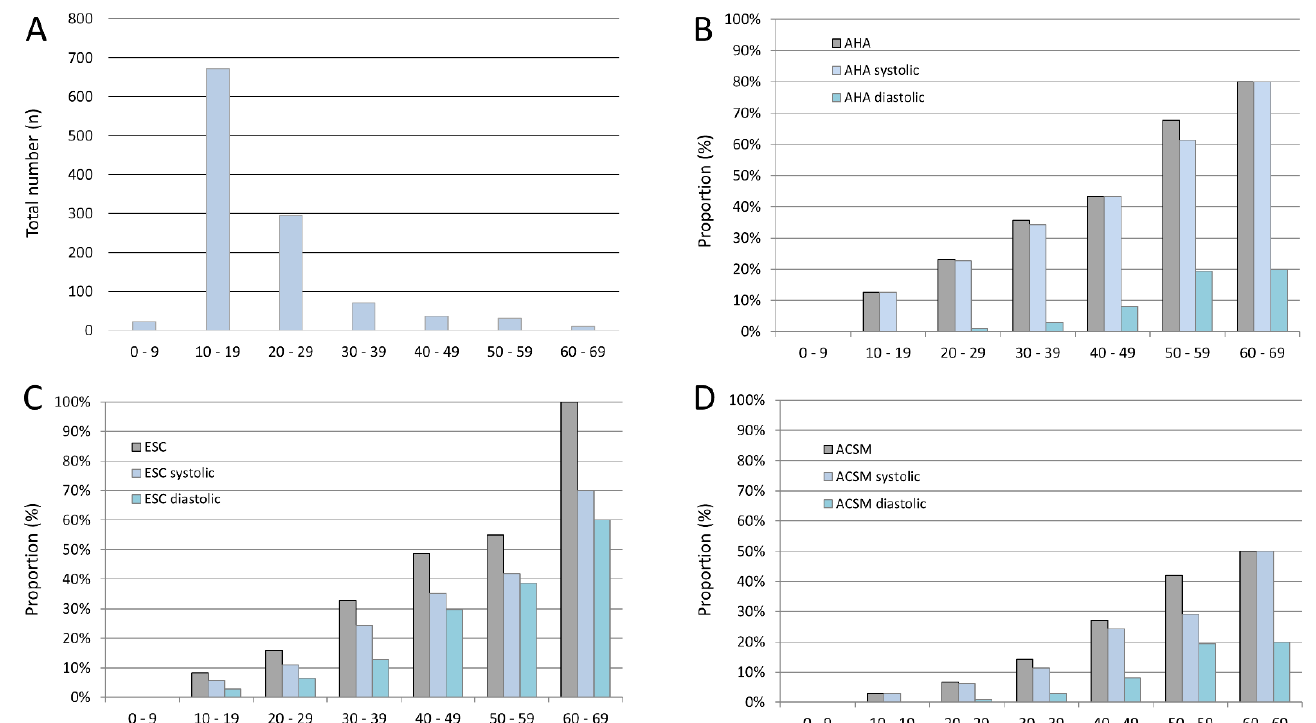
Figure 1. Included numbers of athletes and proportion of blood pressure deviations stratified for age by decade. Panel ( A ) Total numbers of included athletes stratified for age by decade. Panel ( B ) Proportion of athletes with exaggerated blood pressure response according to American Heart Association (AHA) guideline stratified for age by decade. Panel ( C ) Proportion of athletes with exaggerated blood pressure response according to European Society of Cardiology (ESC) guideline stratified for age by decade. Panel ( D ) Proportion of athletes with exaggerated blood pressure response according to American College of Sports Medicine (ACSM) guideline stratified for age by decade.